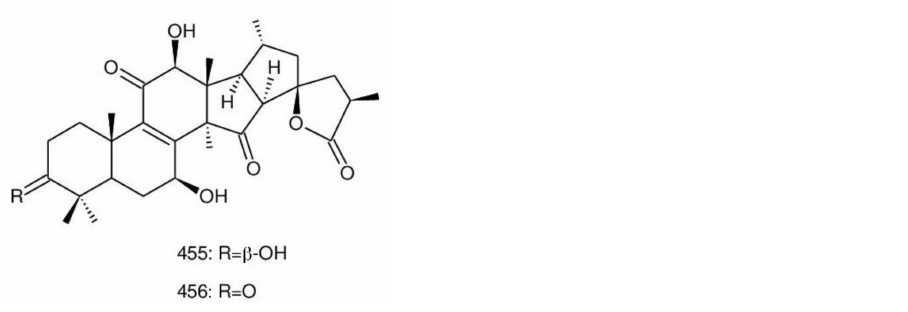
Figure 20. A possible mechanism to account for the formation of 454 .